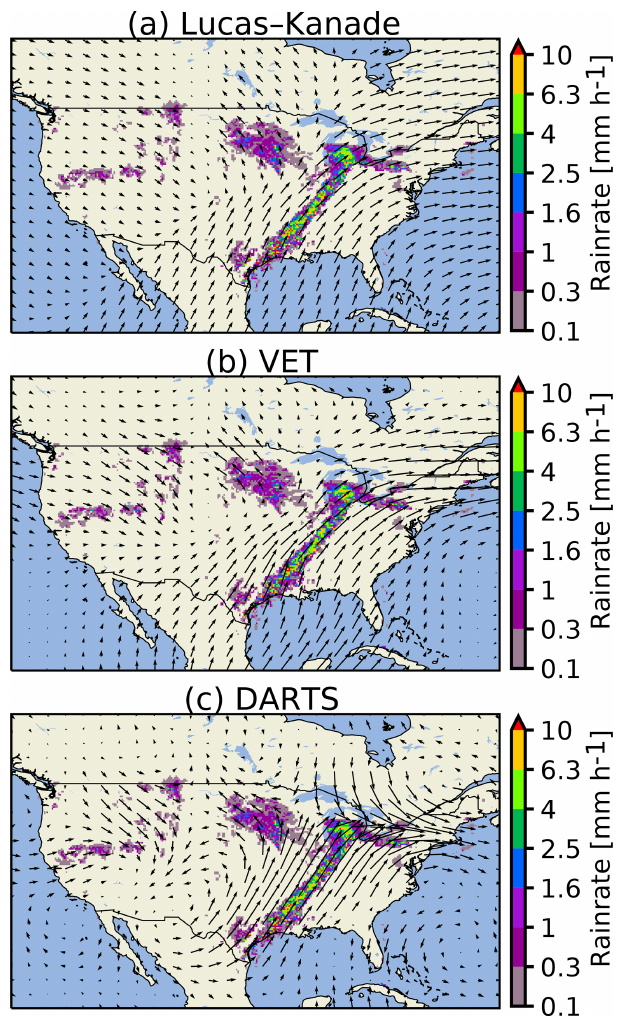
Figure 12. Comparison of advection fields obtained by differ- ent optical flow methods for a selected precipitation event: US, 11 April 2013 at 08:00UTC.